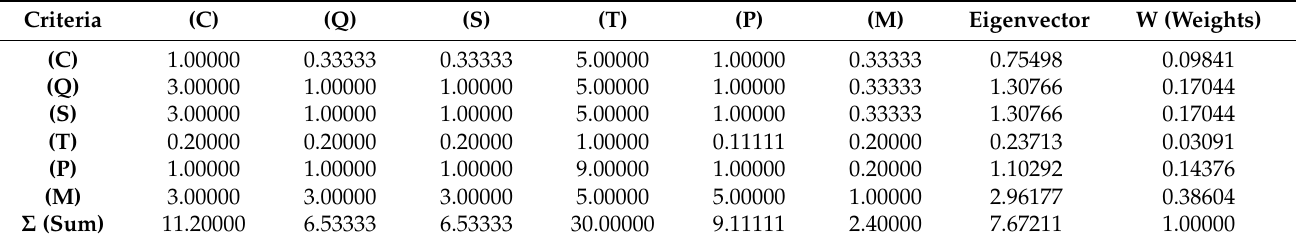
Table 12. Judgment matrix (junior packaging engineer).